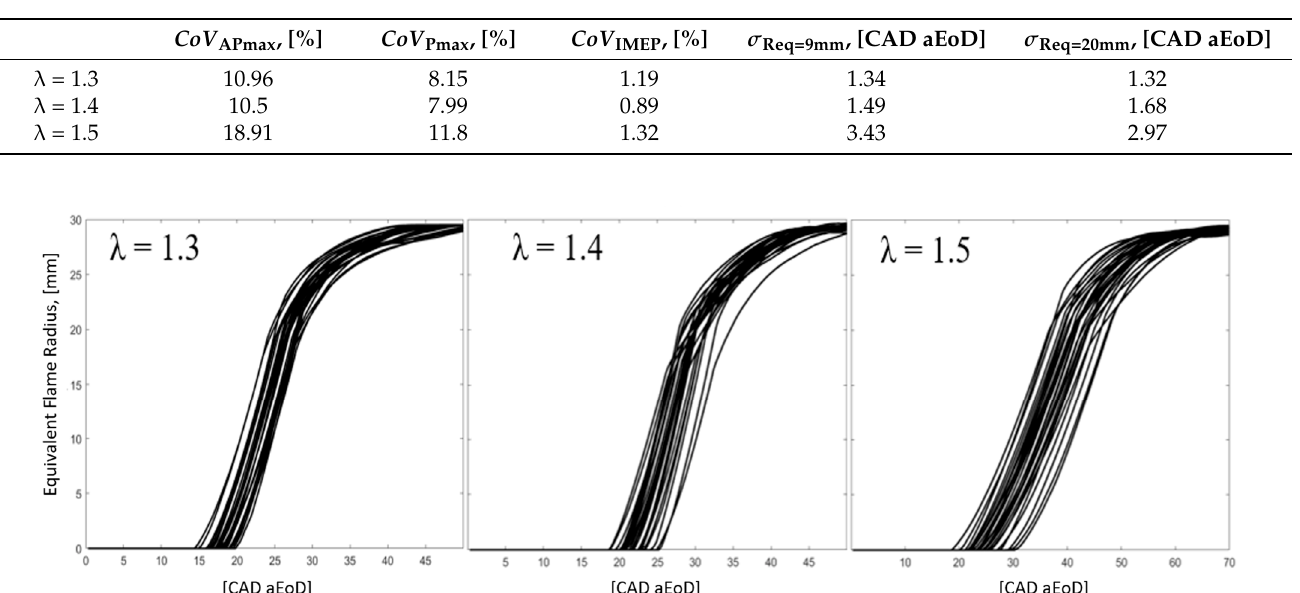
Table 5. Evaluation of the prediction quality by considering quantities related to the input parameters used for the training sessions.